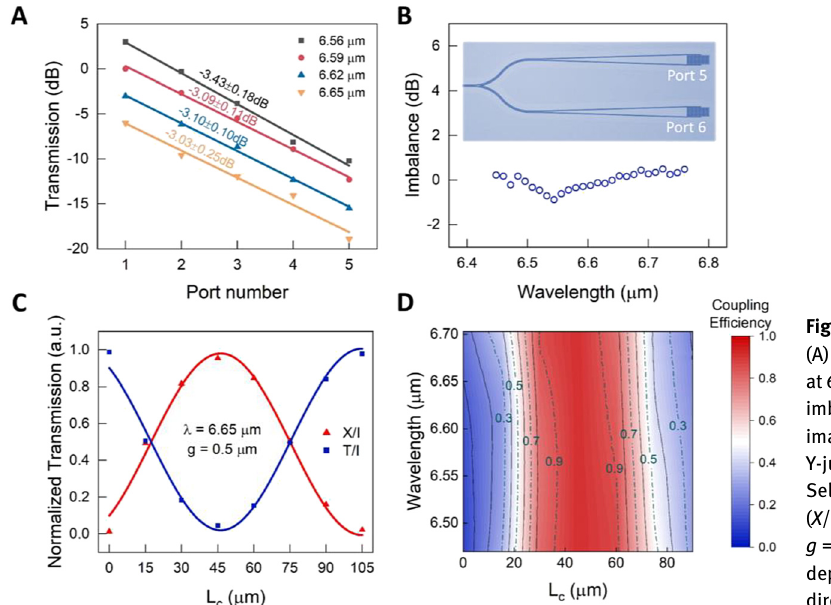
Figure 5: Device characterization. (A) Cutback results of the cascaded Y-junction